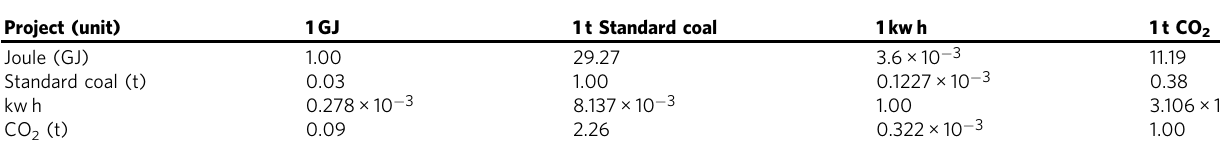
Table 2 Conversion factors of different energy units.